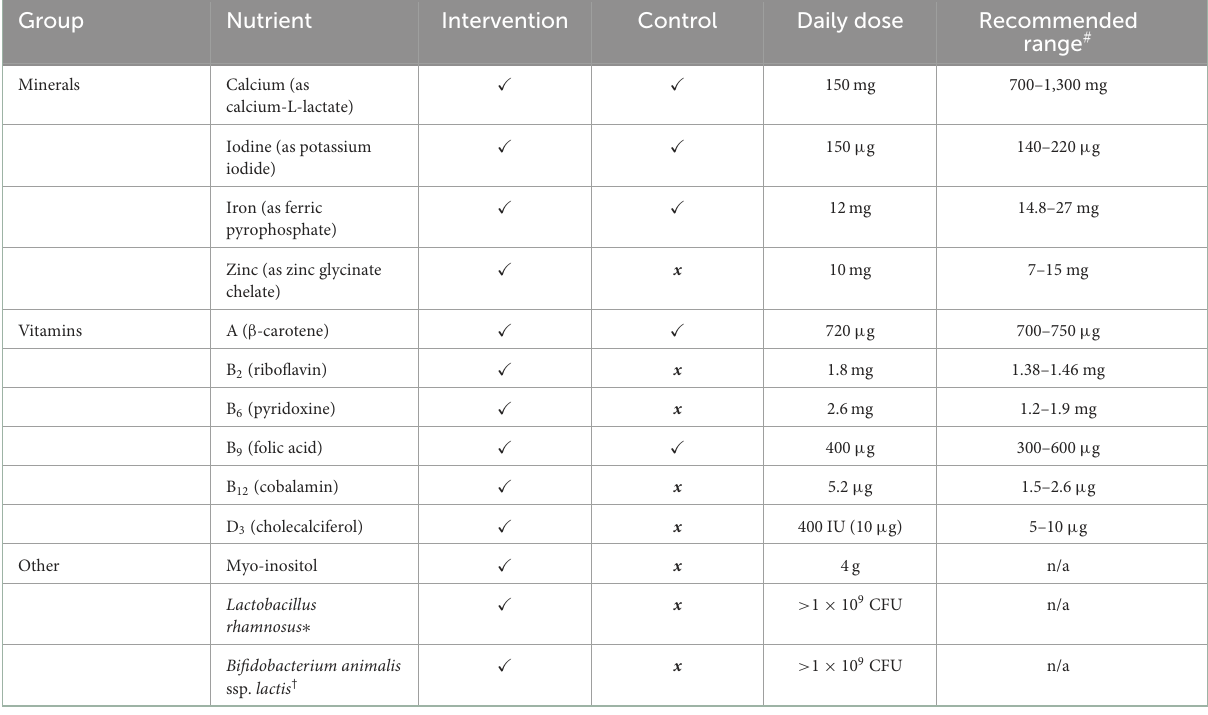
TABLE 1 Detailed nutrient composition of the intervention and control drinks in the NiPPeR study. Group Nutrient Intervention Control Daily dose Recommended